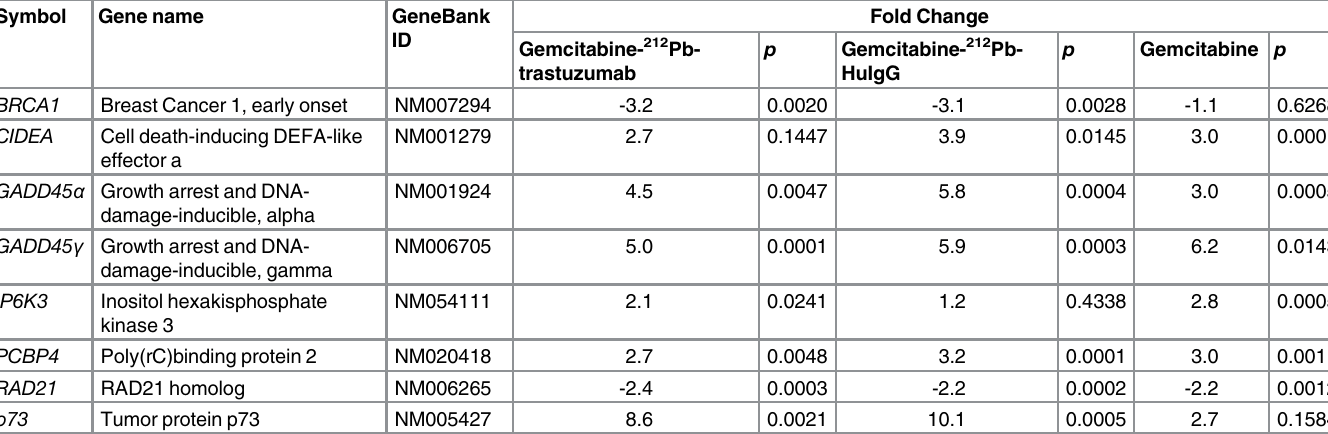
Table 1. Differential expression of genes involved in apoptosis in LS-174T i.p. xenografts following treatment with Gemcitabine and α